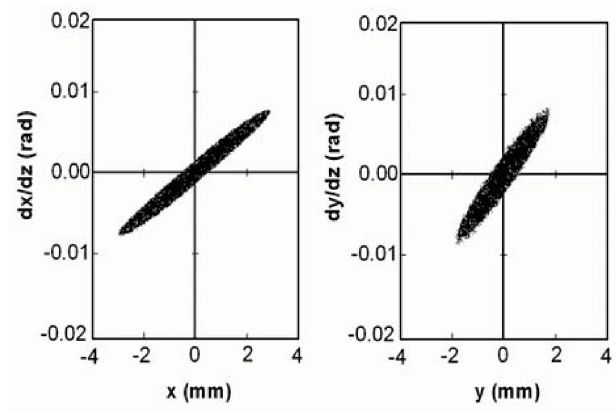
FIG. 13. (Color) TE101 (a) and TE102 (b) modes in the rf deflector for f (cid:4) 1200 MHz